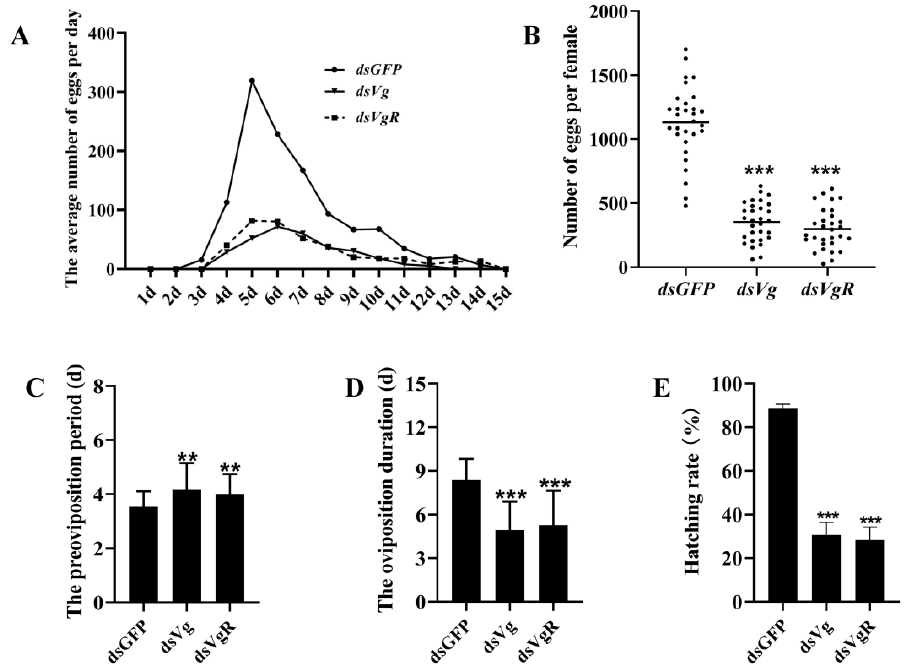
Figure 7. The effect of RNAi-mediated knockdown of SfVg and SfVgR on the reproduction of S. frugiperda female adults. ( A ) The average number of eggs per day. ( B ) The number of eggs per female. The horizontal line represents the median. ( C ) The preoviposition period. ( D ) The oviposition duration. ( E ) The hatching rate. The asterisks indicate statistically significant differences and ns represents no significant difference between each treatment ( t -test: ** p < 0.01, *** p < 0.001).